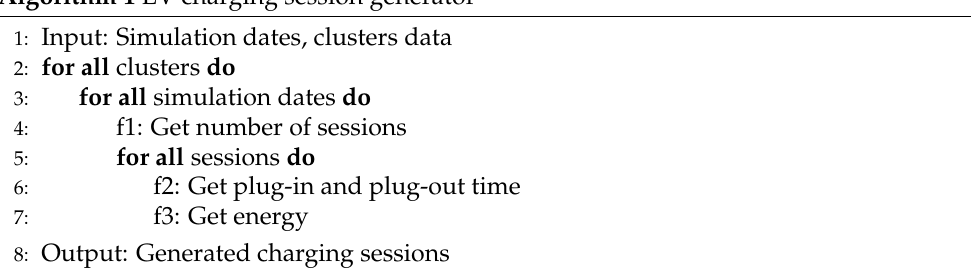
Algorithm 1 EV charging session